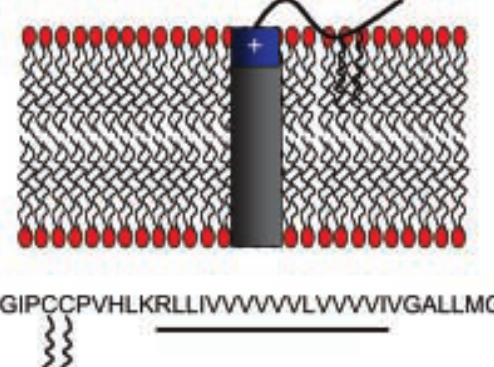
Structure of SP-C. The cylinder represents the a -helix of SP-C, covering residues 9–34 in the structure determined by NMR, and which cor- responds to the thickness of a fluid dipalmi- toyl-phosphatidylcholinebilayer. The plus sign in the N-terminal part of the helix corresponds to the evolutionarily conserved Lys11–Arg12 dibasic pair. The two palmitoyl groups linked to Cys5 and Cys6 are depicted by wavy lines. The amino acid sequence of human SP-C is given using one-letter abbreviations for the amino acid residues. The discordant region is under-